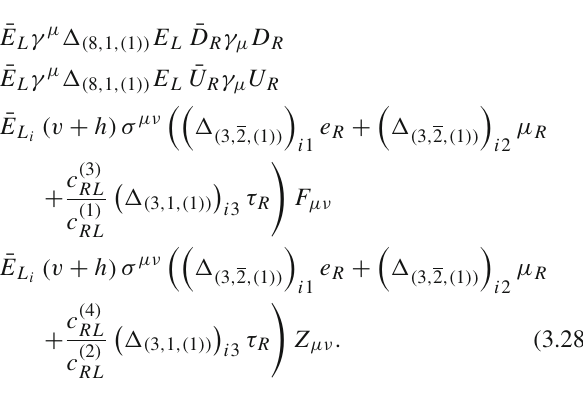
Table 5 Lower bounds on the NP scale for some representative effective dimension 6 operators. The values of (cid:4) are at 95% C.L. and are obtained considering that only the operators of the same class contribute to the given observables. No cancellations among the corresponding coefficients are allowed